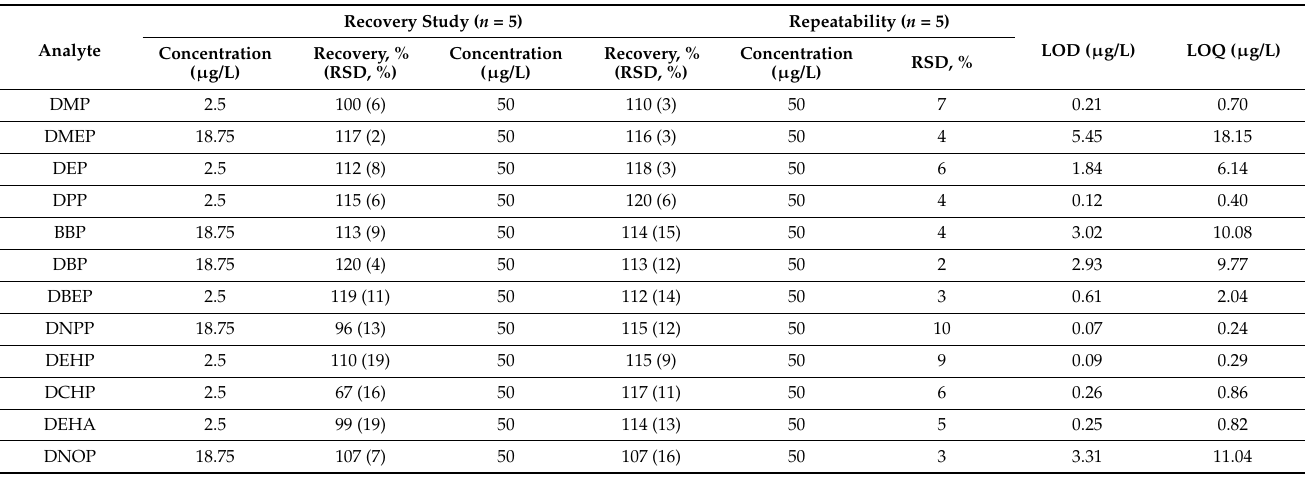
Table 2. Recovery values ( n = 5), repeatability ( n = 5) and LODs and LOQs of the VA-LLME-UHPLC- MS method in kombuchas.